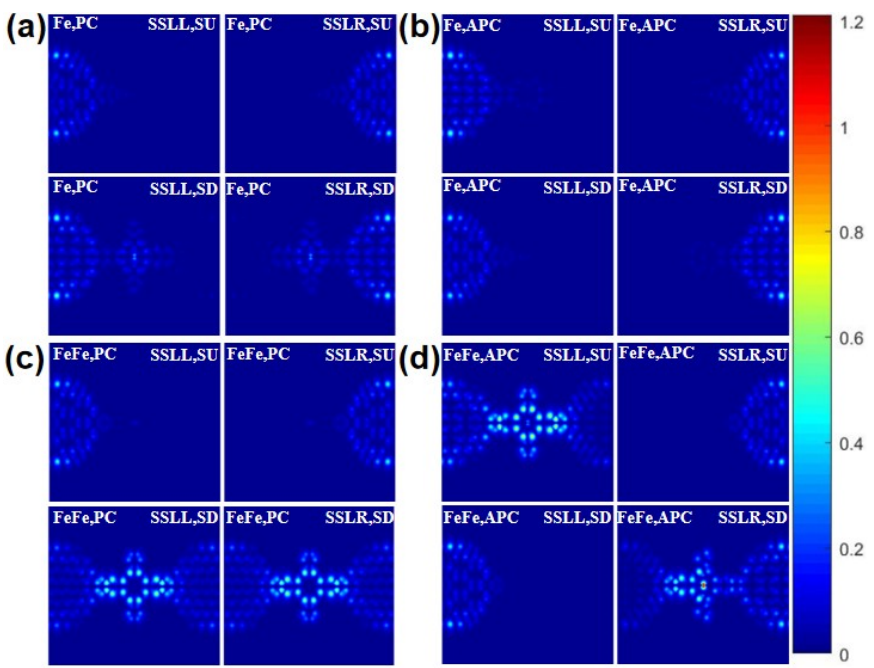
Figure 5. The scattering states of the FePc in the PC ( a ) and APC ( b ), and FePc-FePc MDs in the PC ( c ) and APC ( d ) at zero bias.